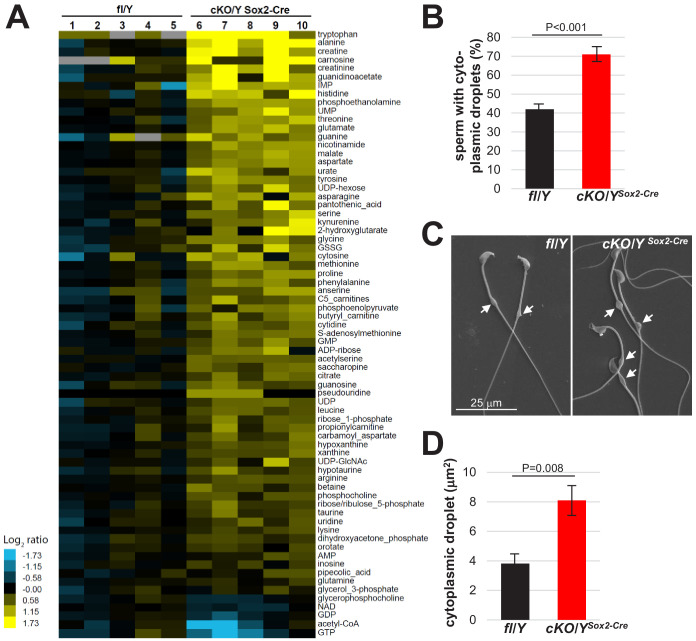
Increased size of cytoplasmic droplet in caudal sperm of males lacking Rlim.(A) Cauda epididymal sperm were collected from 8-week-old fl/Y or cKO/YSox2-Cre mice and polar metabolites were determined via LC-MS. Samples were run and data analyzed by the Metabolite Profiling Core Facility at the Whitehead Institute. Note general increased content of metabolites in cKO/YSox2-Cre sperm. (B) Cauda sperm was collected from 8-week-old fl/Y or cKO/YSox2-Cre mice and after 10 min separation, immediately fixed in 2.5% glutaraldehyde followed by SEM analysis. Sperm with or without cytoplasmic droplets were counted. n = 250, each. (C) Increased size of cytoplasmic droplets in cKO/YSox2-Cre sperm. Representative images are shown. Droplets are indicated by arrows. (D) Increased size of cytoplasmic droplets in cKO/YSox2-Cre sperm. Droplet surface size was determined via ImageJ. n = 100, each.